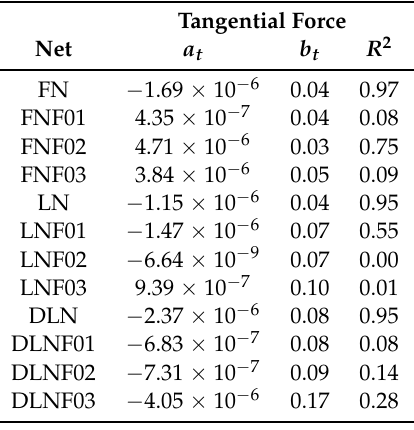
Table 6. Coefficients a and b for C Dt = a t ( S n ) Re + b t ( S n ) fitting for tangential drag coefficient experiments.